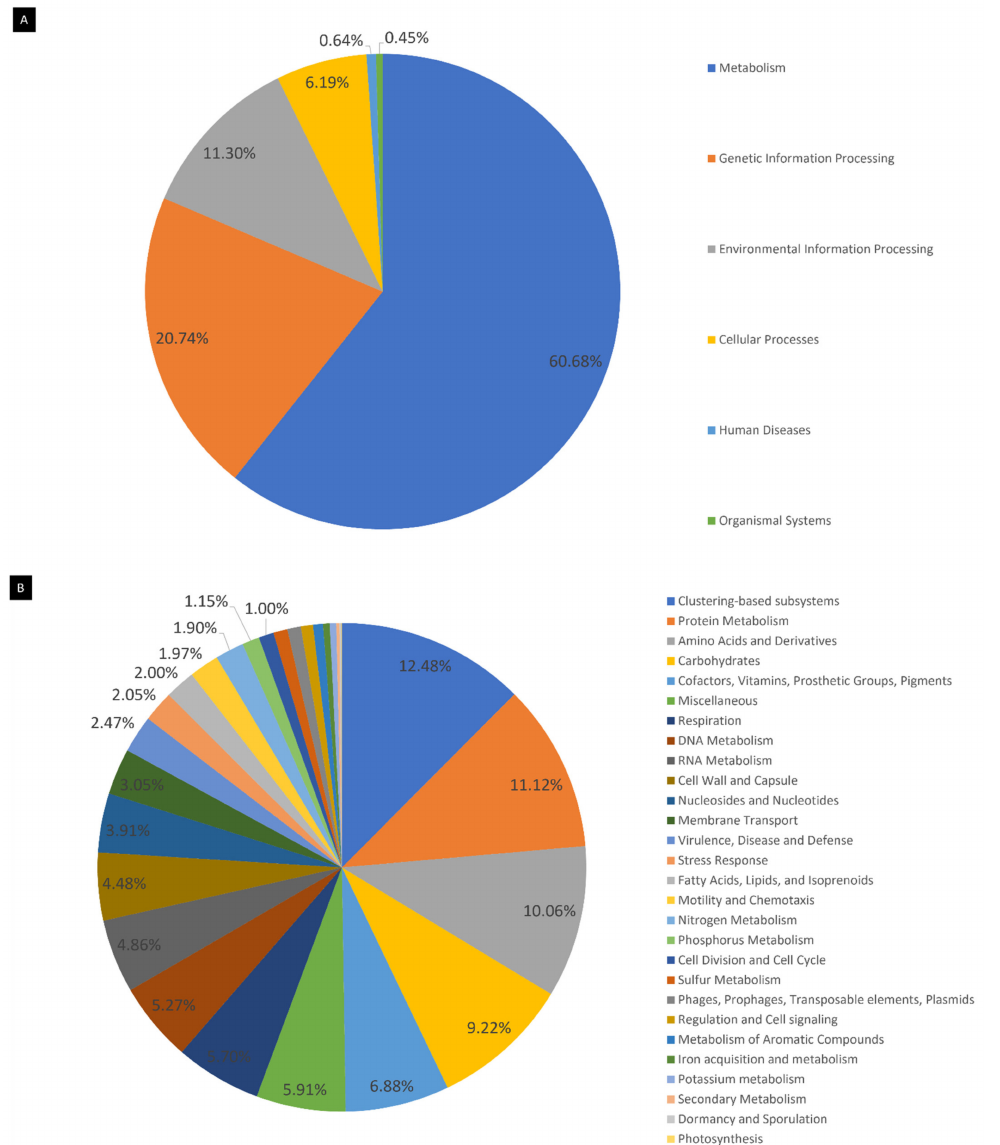
Figure 4. Pie charts of the functional categorization of reads. ( A ) KO database alignment; 60.7% of the features were assigned to the Metabolism category, 20.7% to Genetic Information Processing and 11.3% to Environmental Information Processing. ( B ) Subsystems database alignment; 12.5% of the features were categorized as Clustering-based subsystems, 11.1% as Protein Metabolism, 10.1% as Amino Acids and Derivatives, 9.2% as Carbohydrates, 6.9% as Cofactors, Vitamins, Prosthetic Groups and Pigments, 5.9% were assigned to the Miscellaneous category and 5.7% to